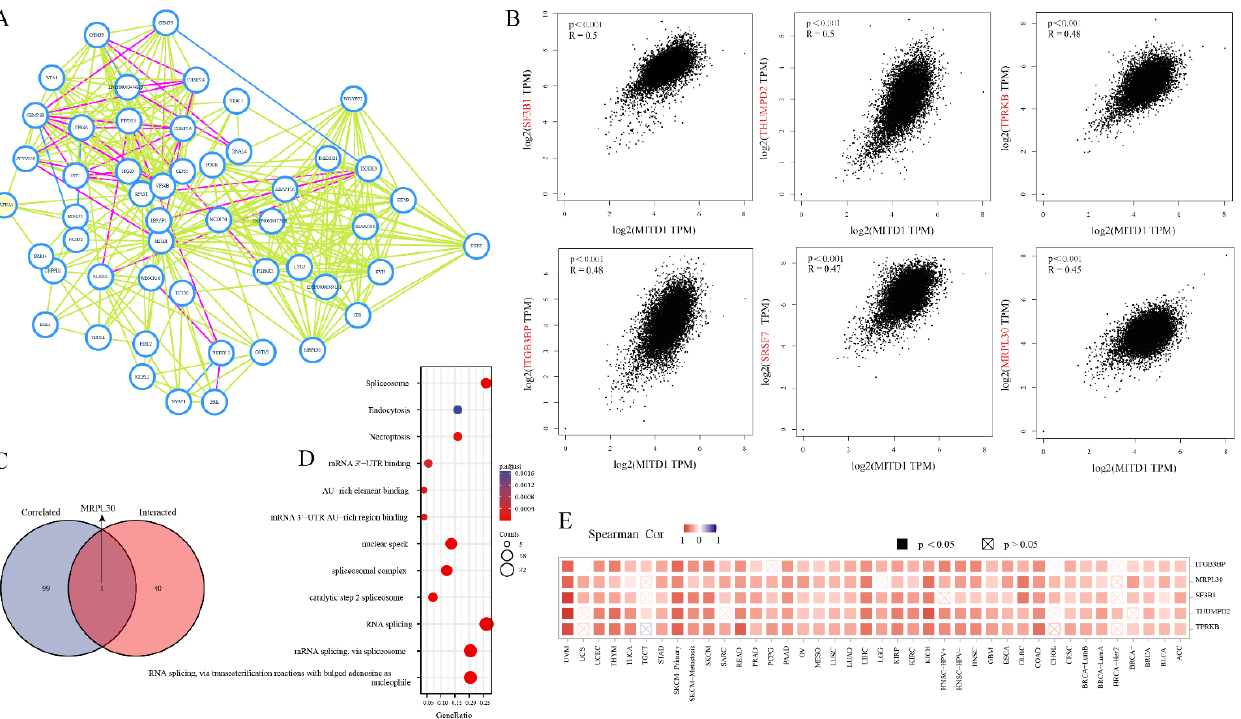
Figure 5. Enrichment analysis MITD1-related gene. ( A ) The interaction network of MITD1-binding proteins. ( B ) The correlation between MITD1 and selected genes from GEPIA2 tool. ( C ) Venn diagram view of MITD1-binding and correlated genes. ( D ) GO and KEGG analysis was displayed based on the MITD1-binding genes. ( E ) The corresponding heatmap data in different cancer